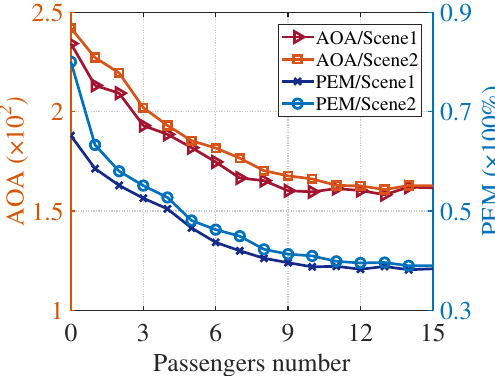
Figure 12. Comparision of the variation of features in two